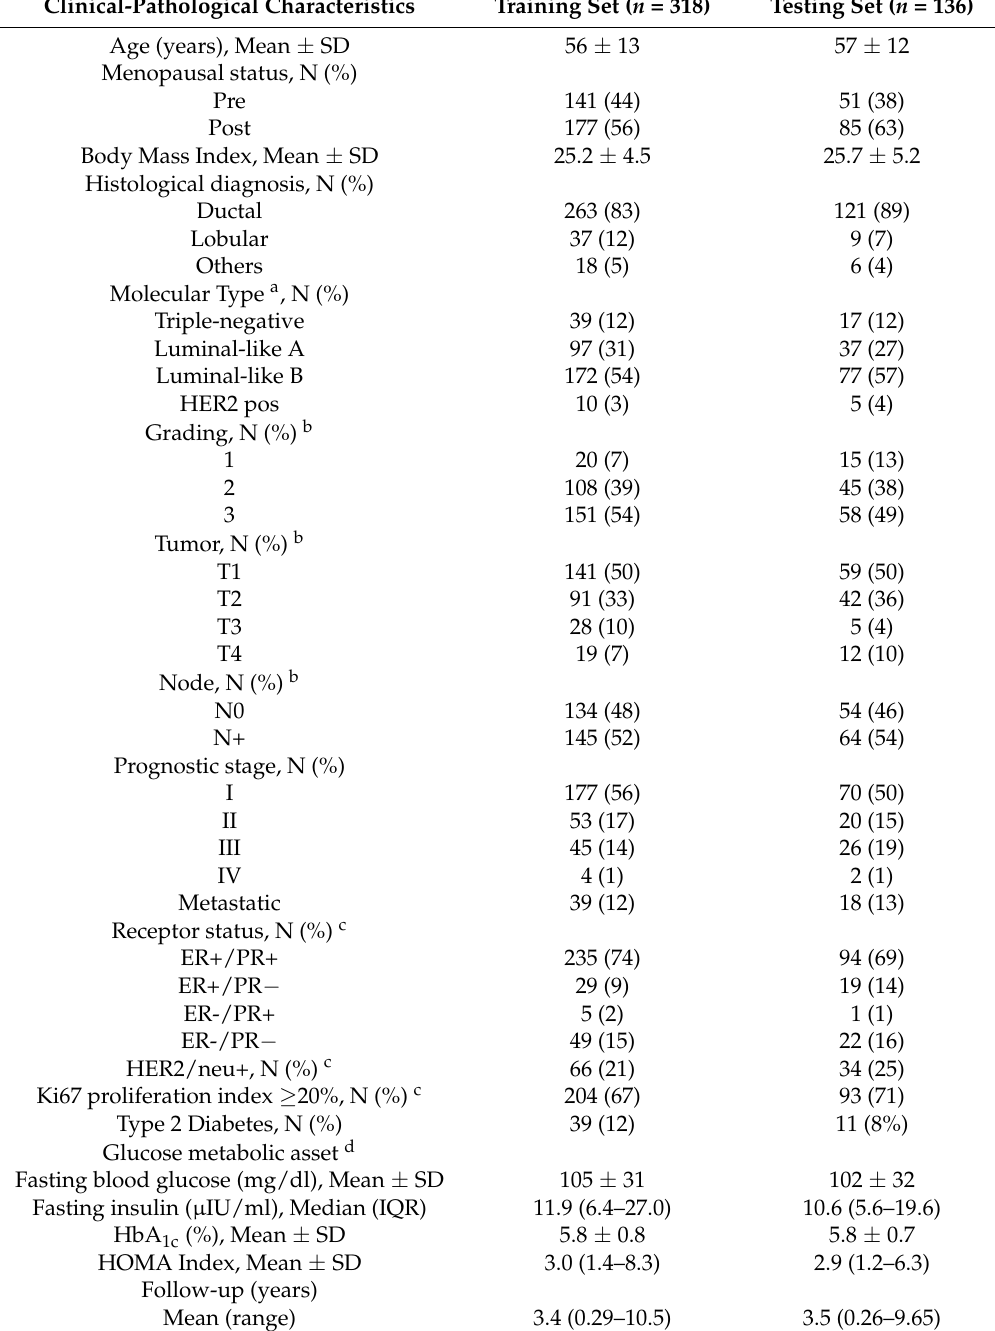
Table 4. Clinical-pathological characteristics of breast cancer (BC) patients. Comparison between training and testing